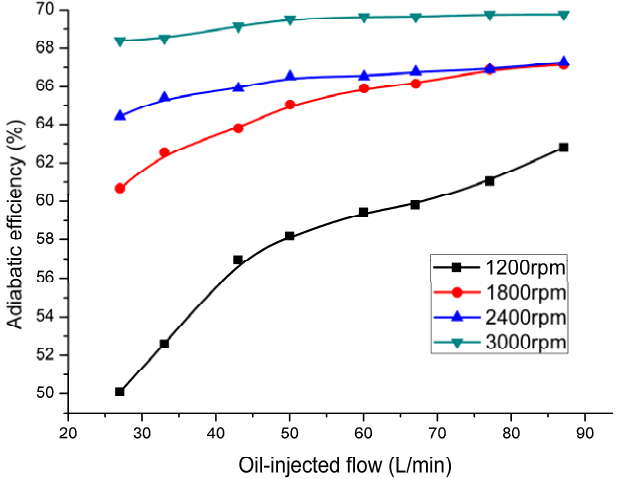
Figure 8. Variation of adiabatic efficiency with different oil ‐ injected flow rates.